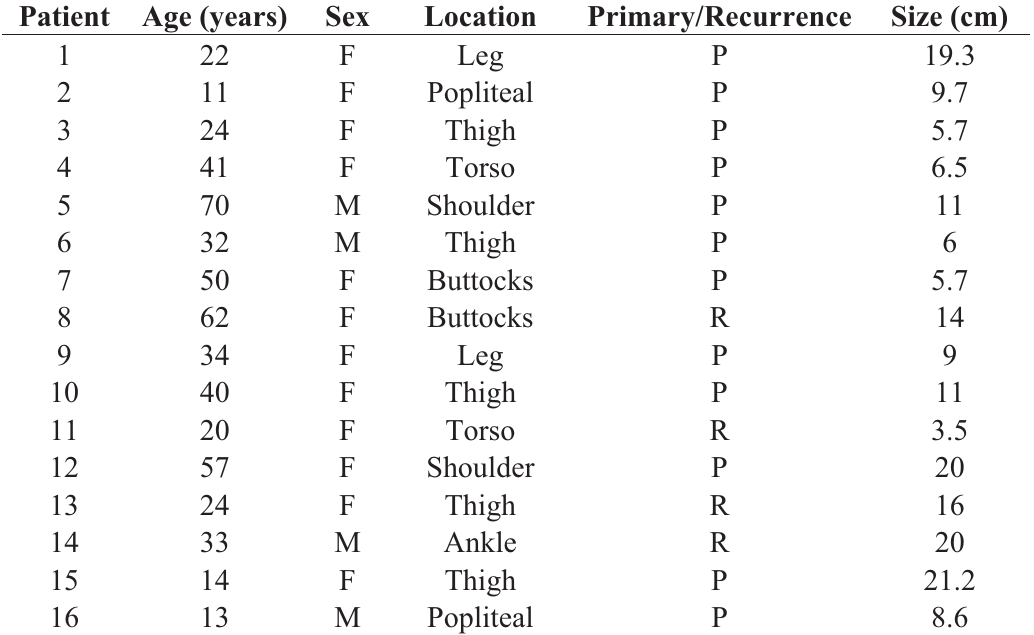
Table 1. Demographic information for patients in the present study who received chemotherapy for treatment of fibromatosis.